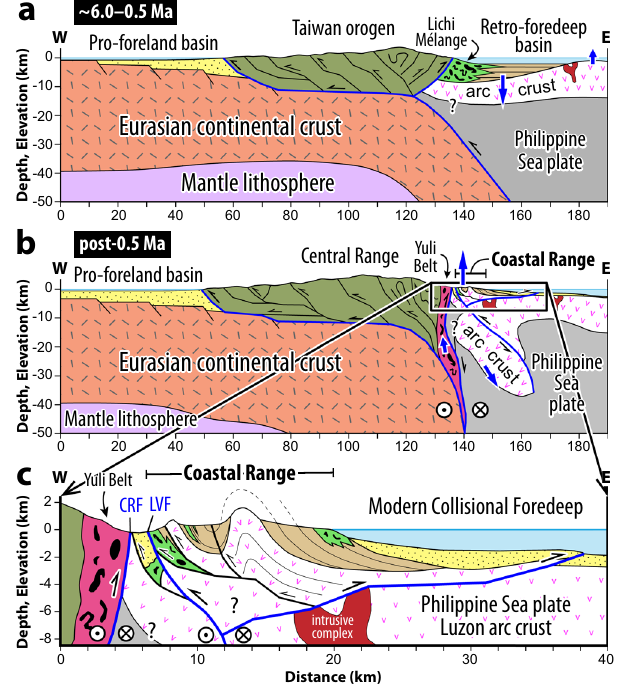
Fig. 4 Conceptual model for the history of vertical motions (blue arrows) of the Philippine Sea plate arc crust in the past ~6 Ma. a Forebulge uplift and foredeep subsidence occur on the Luzon arc crust during 6 – 0.5 Ma, in response to eastward migrating orogenic load 33,34 . b Post-0.5 Ma rapid uplift due to transpressional deformation and isostatic rebound of the overriding plate 4,5,59 . c Representative structural cross-section in the modern Coastal Range 34,57 . Blue lines mark major boundary faults. LVF Longitudinal Valley fault; CRF Central Range